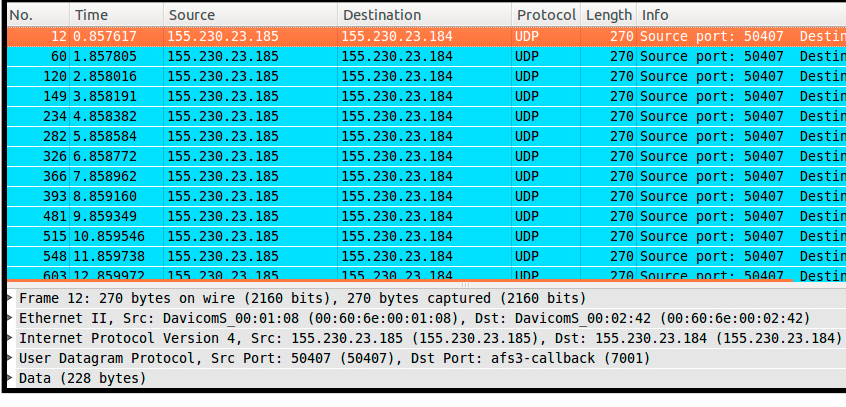
Figure 27. Packet capture (between DMCs). Electronics 2019 , 8 , x FOR PEER REVIEW